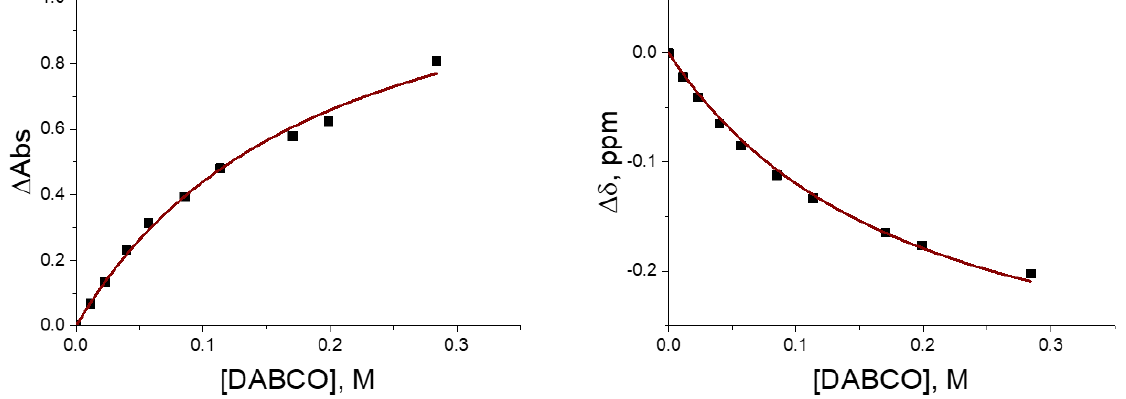
Figure 10. Dependencies of the Δ Abs and Δδ values in the solutions with constant concentration of CHI 3 (0.01 M) and variable concentrations of DABCO. Solid lines show the simultaneous multivariable fitting of the UV–Vis and NMR titrations data.